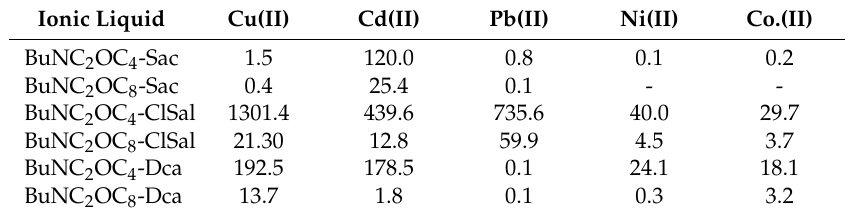
Table 2. Distribution ratio ( D ) for metal aqueous nitrate salt with BuNC 2 OC 4 (C 8